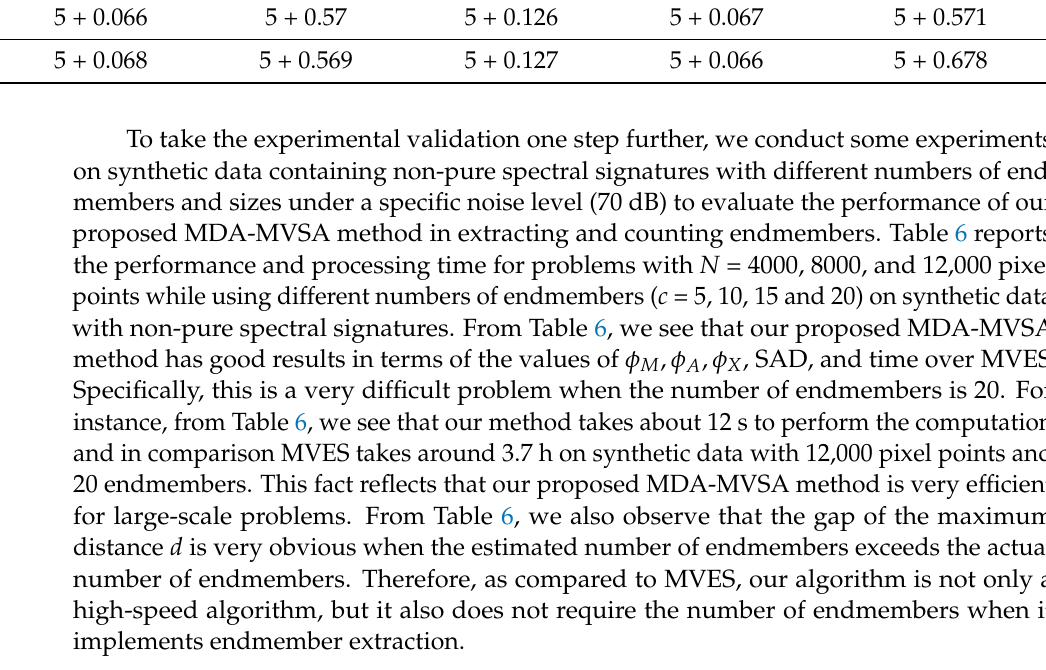
Table 6. Performance and processing time (seconds) obtained with our method and minimum-volume enclosing simplex (MVES) on synthetic data with N = 4000, 8000, 12,000, SNR = 70 dB, c = 5, 10, 15, and 20, and maximum purity of 0.8. ˆ c is the estimated number of endmembers, and d is the maximum distance between all pixel points and the affine hull formed by all extracted